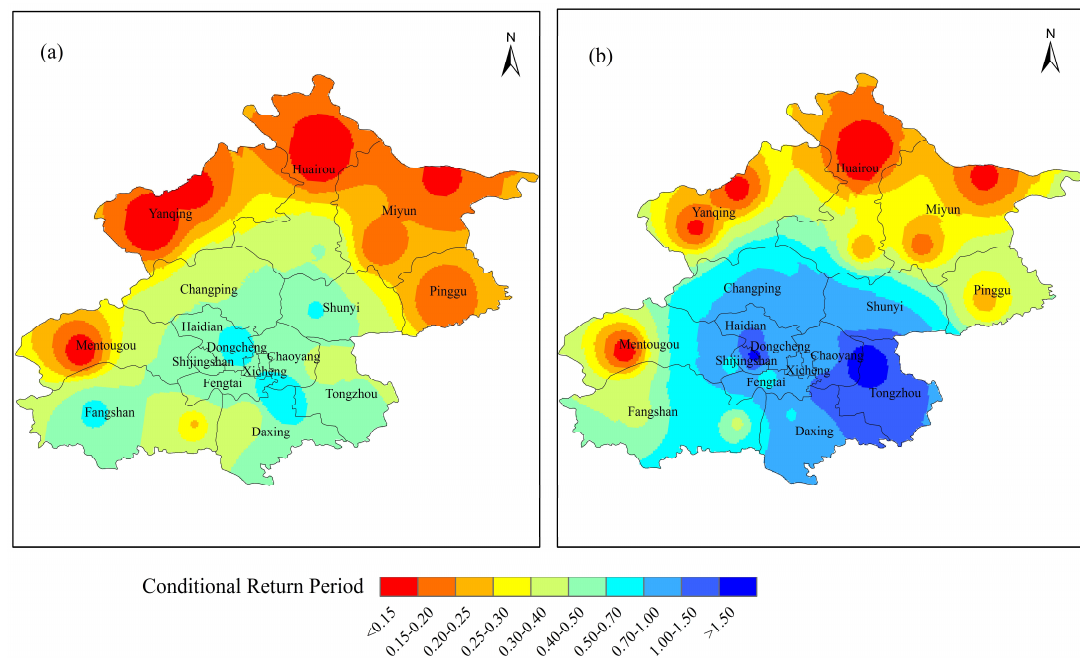
Figure 5. Spatial distributions for the conditional return periods for low temperature events with a duration exceeding 3 days for study periods: ( a ) 1978–1998; ( b ) 1999–2015 (unit: year). Atmosphere 2018 , 9 , x FOR PEER REVIEW The spatial distributions for